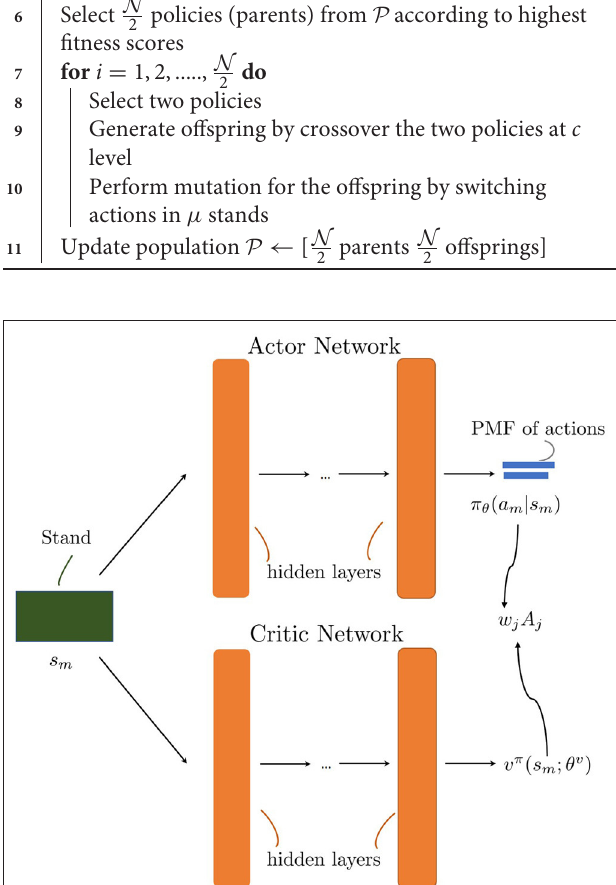
FIGURE 2 | Actor and critic networks with their interaction to compute the weighted advantage that is needed for the gradients.